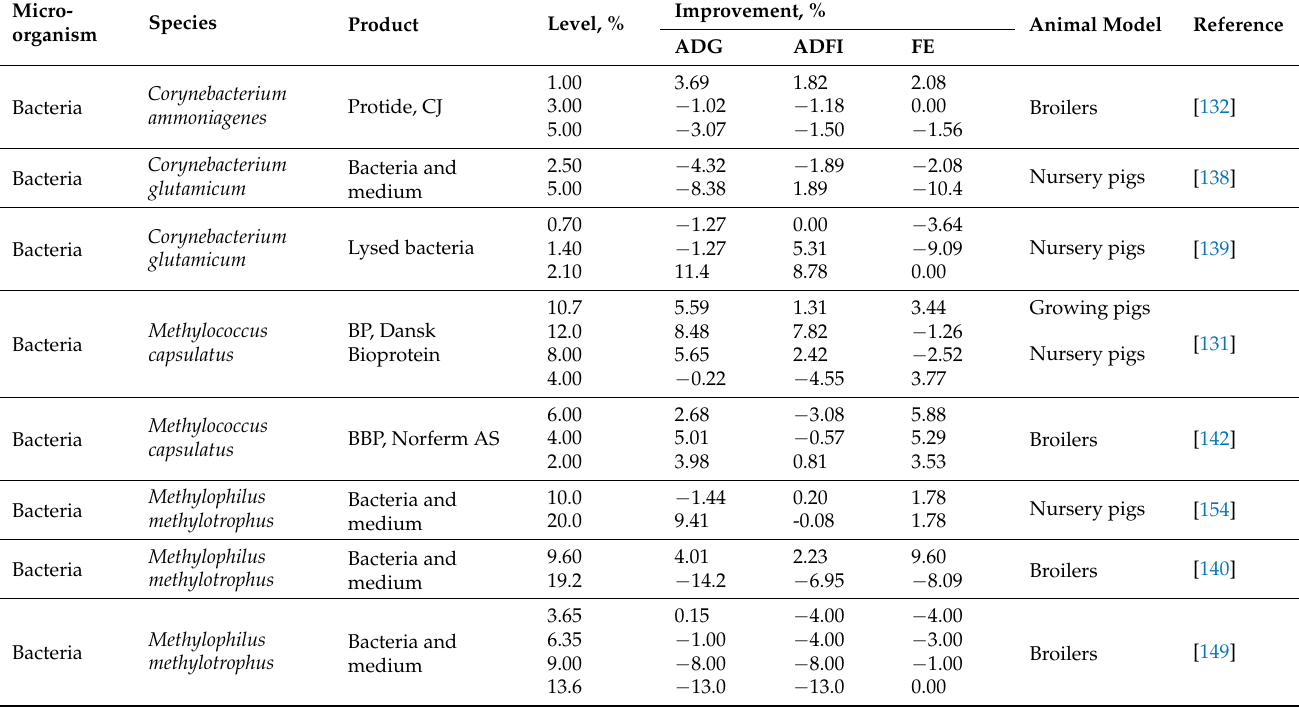
Table 5. Single-cell proteins from bacteria and their impacts on growth